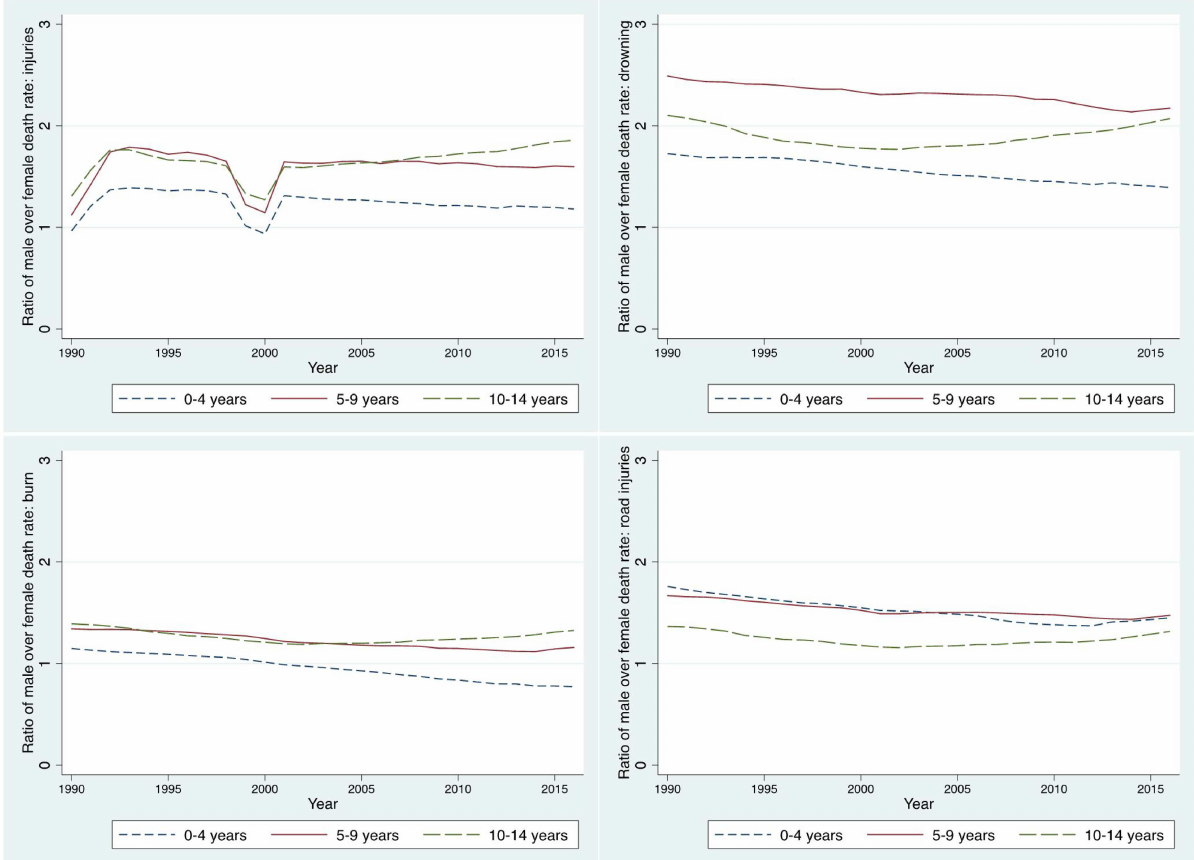
Fig 2. The ratio of male over female fatality rate due to all injuries (upper left), drowning (upper right), fire, heat and hot substance (lower left), and road injuries (lower right) by age group in Ethiopia: 1990–2016. Source: Global Burden of Disease 2016.